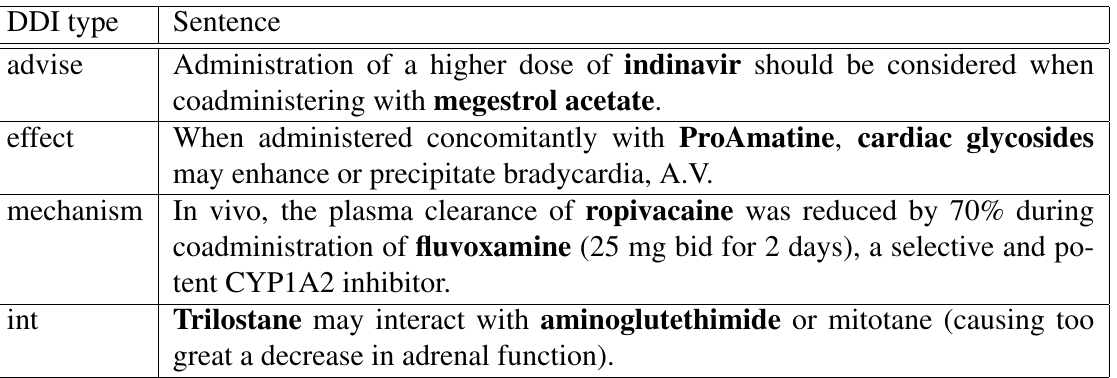
Table 1: Examples of interactions from the DDI corpus. The entities that constitute the interaction are